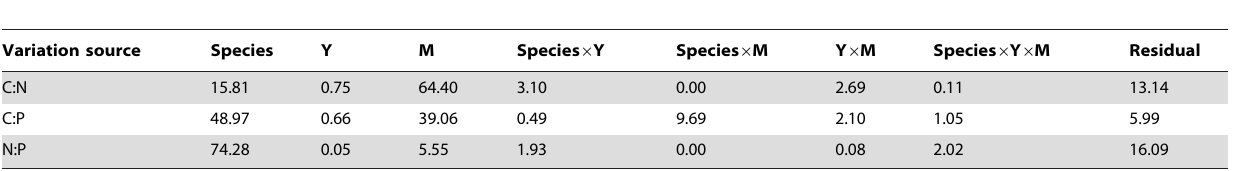
Table 4. Partitioning of total variation (%) of C:N, C:P, N:P into species, sampling year (Y), sampling month (M) and residual components in the field